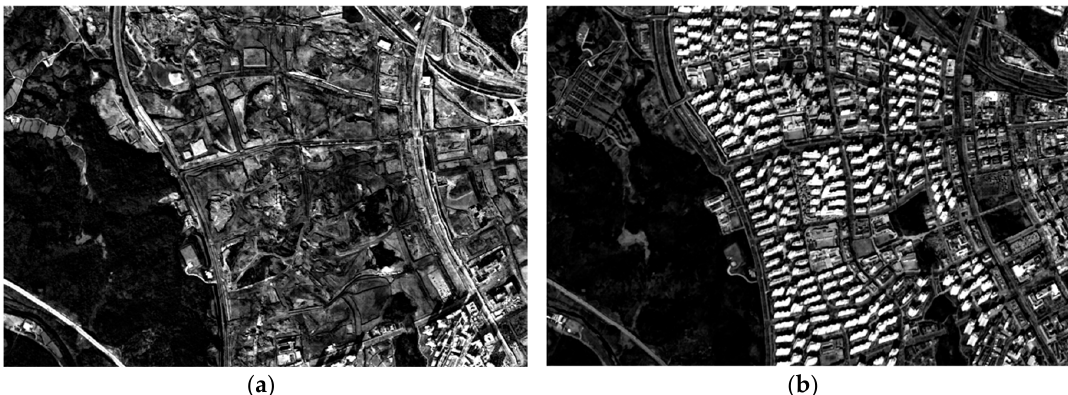
Figure 3. Morphological building index (MBI) feature images of the first subset: ( a ) MBI T1 and ( b ) MBI T2.